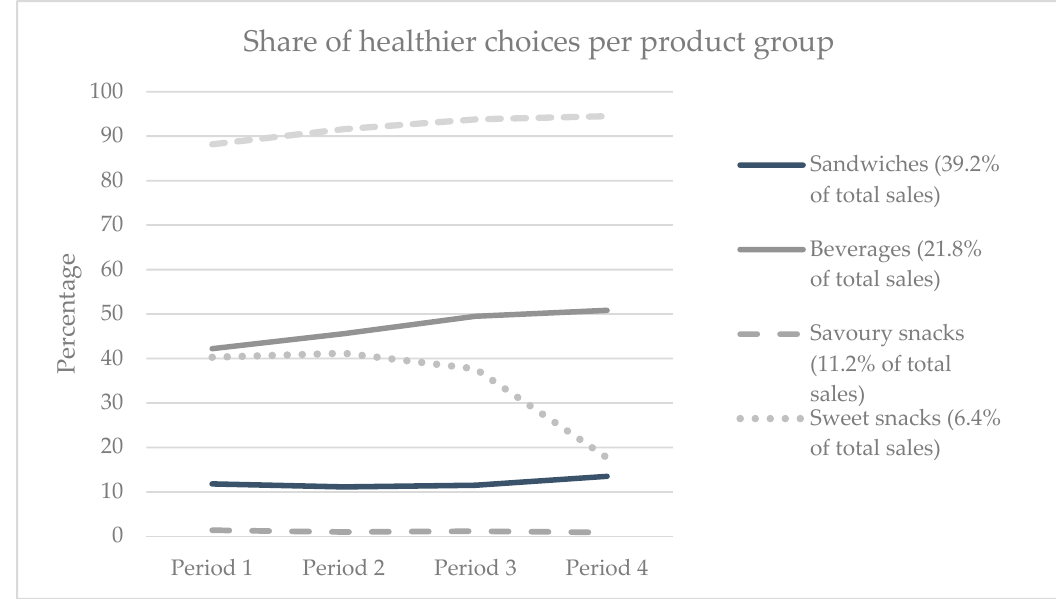
Figure 1. Share of healthier products across four time periods for a selection of product groups.